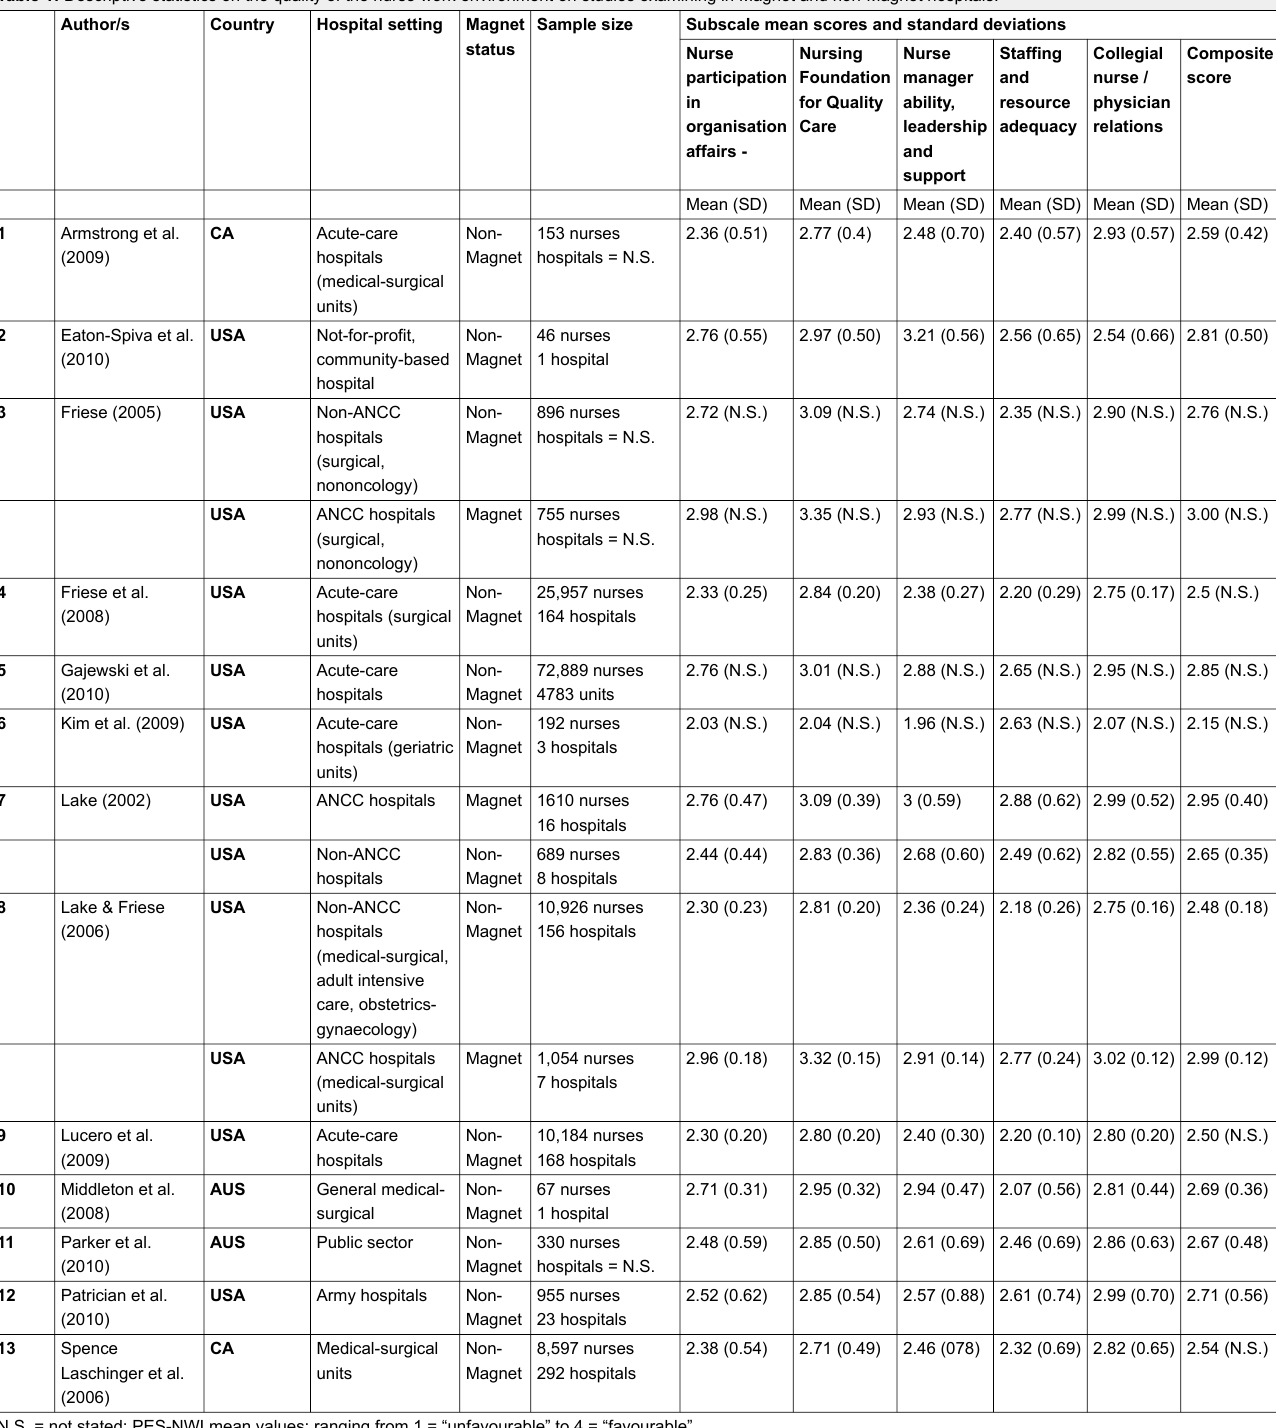
Table 1: Descriptive statistics on the quality of the nurse work environment on studies examining in Magnet and non-Magnet hospitals.